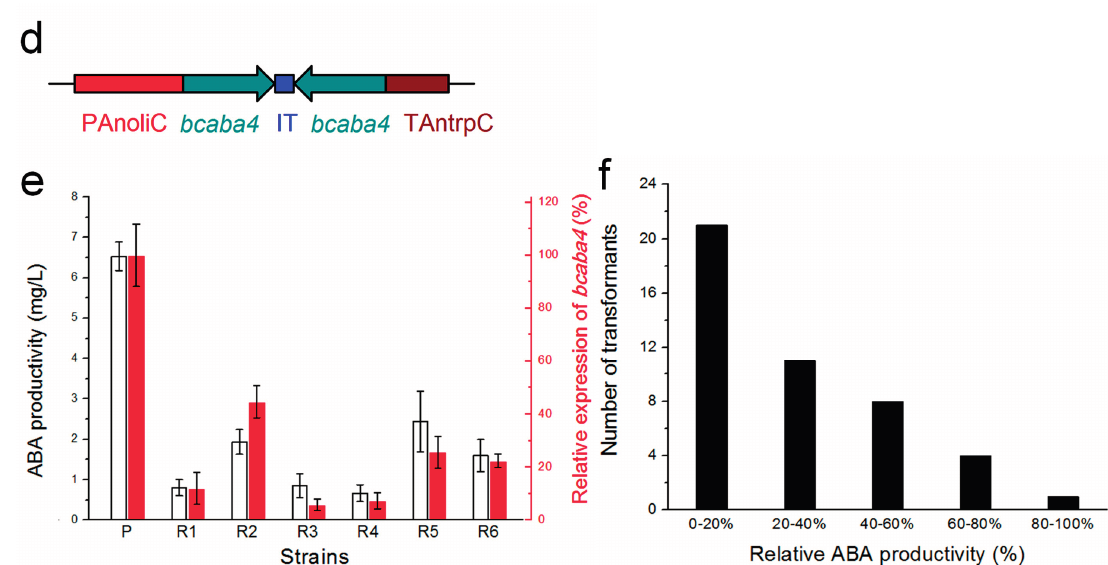
Figure 5. The silencing vector pCBSilent1-ABA4 silenced the bcaba4 gene with high efficiency; ( a ) a commercial S -(+)-ABA was used as the standard sample; ( b ) a moderately high absorption peak corresponding to ABA was detected in the culture medium of the parent strain B. cinerea Bc-6-A4; ( c ) the significantly diminished absorption peak corresponding to ABA was detected in the culture medium of a representative transformant. The absorption peaks corresponding to ABA are indicated by arrows; ( d ) schematic structure of the silencing construct in the vector pCBSilent1-ABA4 which facilitated hairpin RNA generation; ( e ) ABA productivity and expression levels of bcaba4 mRNA in six randomly selected transformants are presented. The transformants were derived from ATMT of the ABA-producing B. cinerea mutant, Bc-6-A4, using the silencing vector pCBSilent1-ABA4. The expression levels of bcaba4 were determined by qRT-PCR and presented as percentage of the value obtained from the parent strain. P: the parent strain Bc-6-A4; R1: a randomly selected transformant whose liquid chromatogram was shown ( c ); R2–R6: five other randomly selected transformants; ( f ) based on